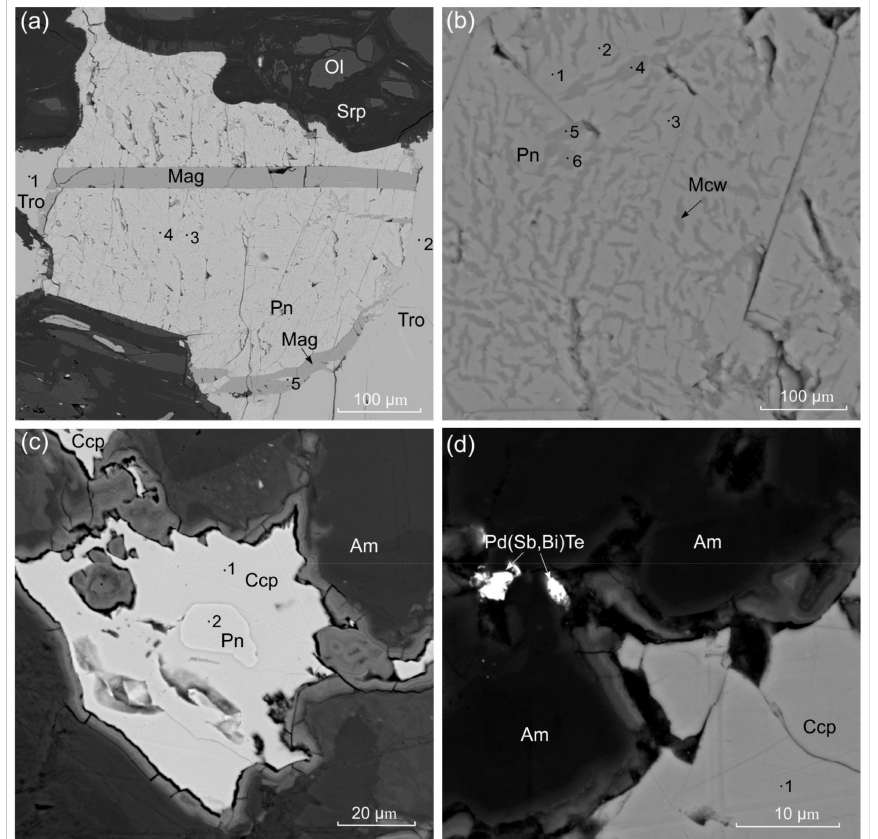
Figure 2. Back-scattered electron image of sulfide minerals: ( a , b ) sample 09-6; ( c , d ) sample 06-02. Am: amphibole, Ccp: chalcopyrite, Mag: magnetite, Mcw: mackinawite, Pn: pentlandite, Ol: olivine, Srp: serpentine, Tro: troilite. The points correspond to the analyses in Table